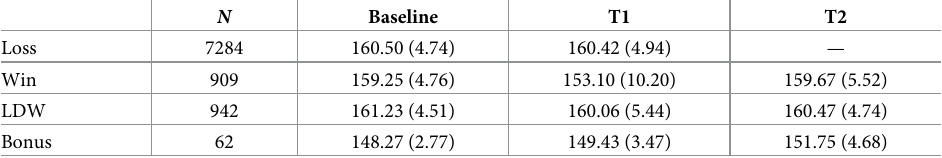
Table 3. Buffalo spirit averaged slot machine screen luminance, measured